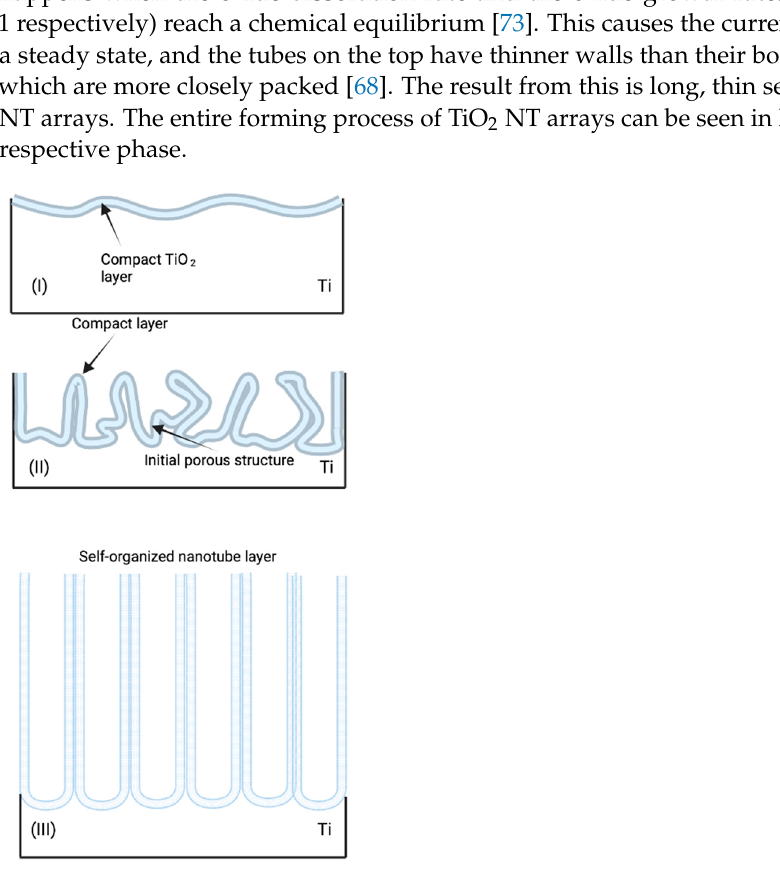
Figure 5. Formation process of TiO 2 by anodization. The process is divided into 3 phases. Phase I consists of the formation of a compact barrier oxide. Phase II consists of the creation of pores after the surface activation by the oxide dissolution. In phase III, the layer of thinner self-organized nanotubes is formed.